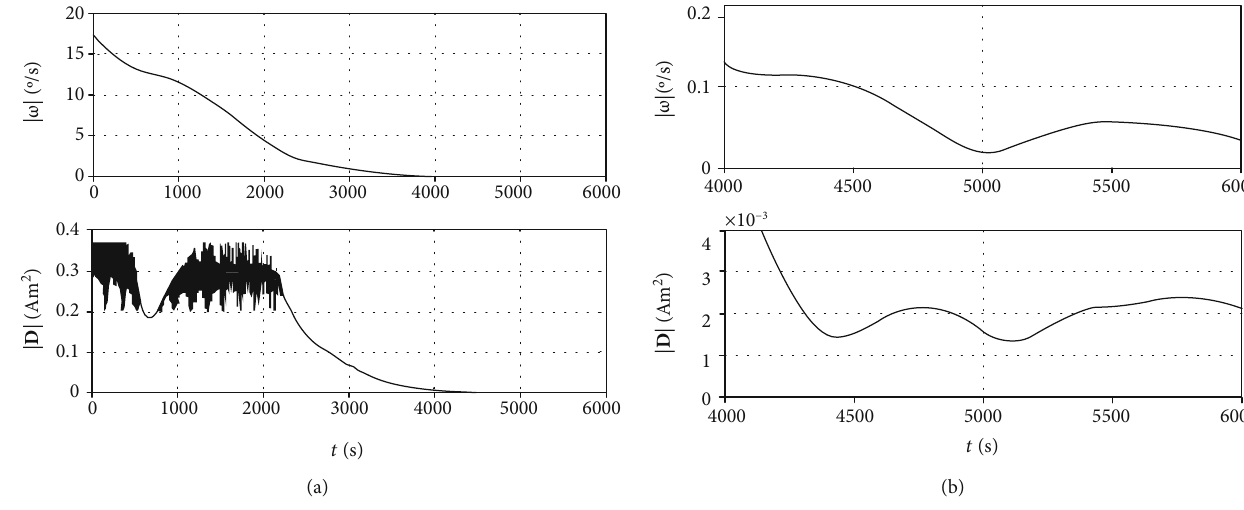
Figure 6: (a) Satellite rate reduction in the detumbling mode; (b) closeup. Table 4: Nominal mode simulation